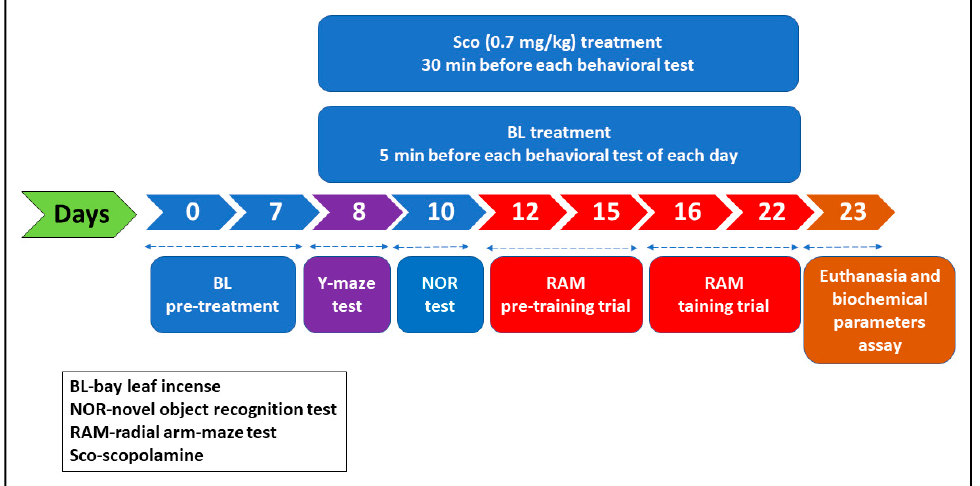
Figure 1. Schematic representation of drug treatment and behavioral analysis.